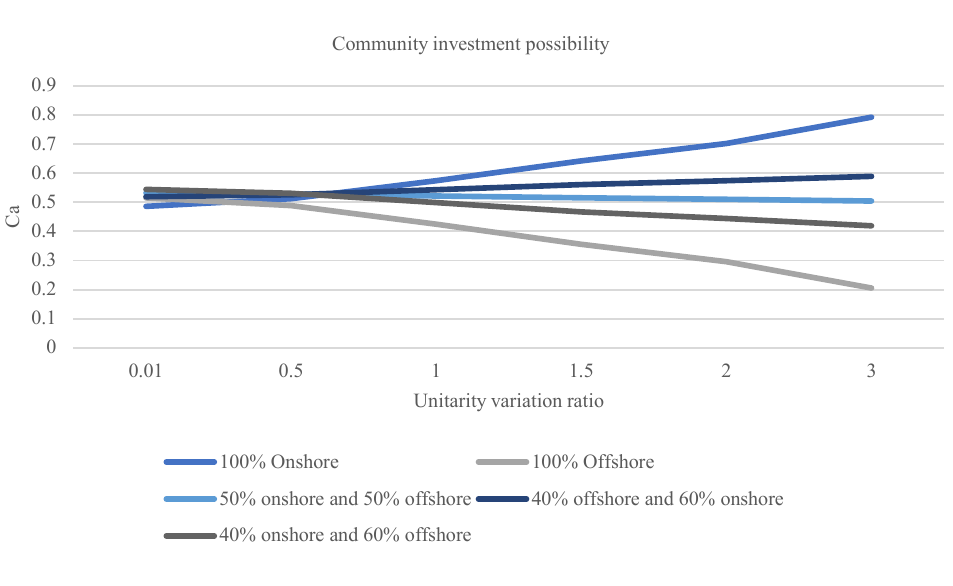
Fig. 5(f). Sensitivity analysis of CO 2 saving.